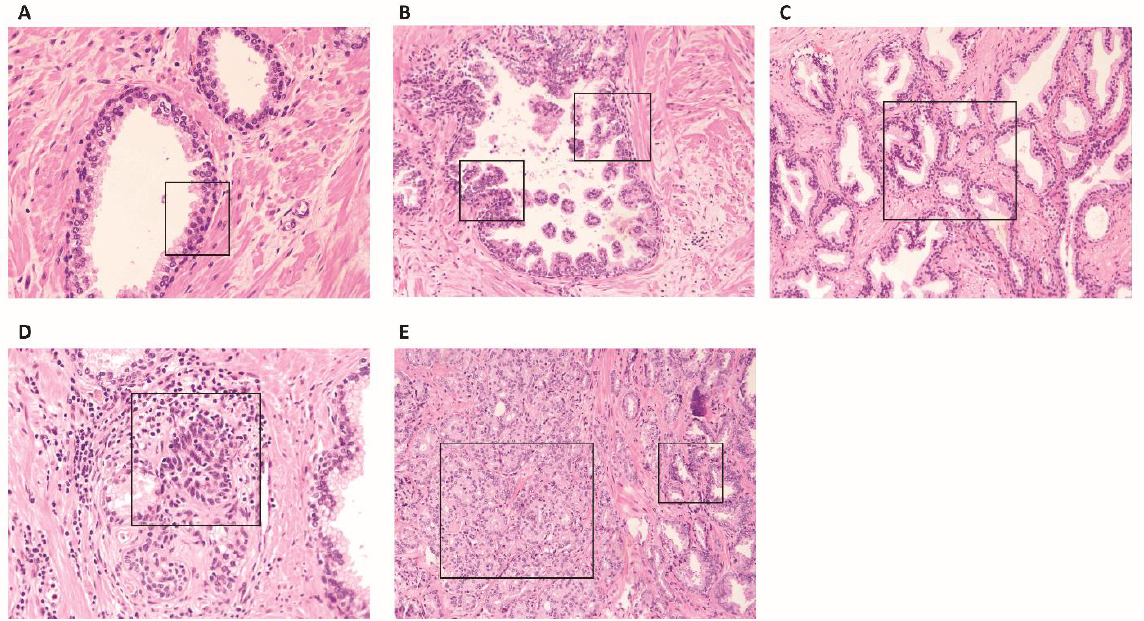
Figure 2. Representative tissue section. ( A ) Normal prostate tissue with epithelial luminal and basal layers and the surrounding stroma tissue (200×). ( B ) Benign prostate hypertrophy (BPH) tissue showing cell proliferation and migration (200×). ( C ) Proliferative inflammatory atrophy (PIA) tissue (100×). ( D ) High-grade prostatic intraepithelial neoplasia (HGPIN) in the peripheral zone of the prostate (200×). ( E ) Prostate cancer tissue (100×).